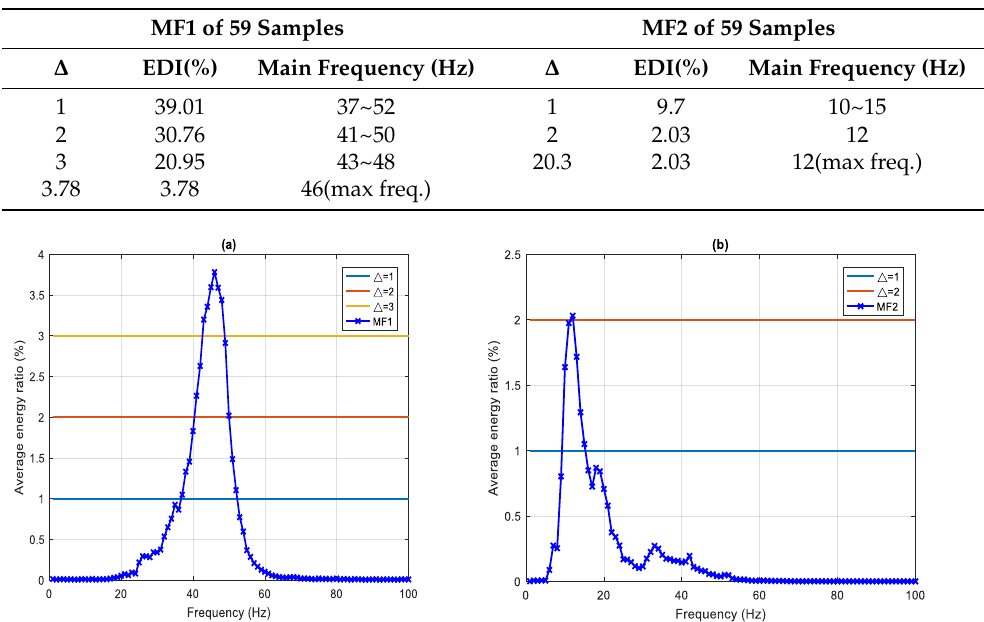
Table 2. MF1 and MF2 of the IMF in 59 samples, EDI, main frequency band, max frequency with thresholds of 1, 2, and 3%.